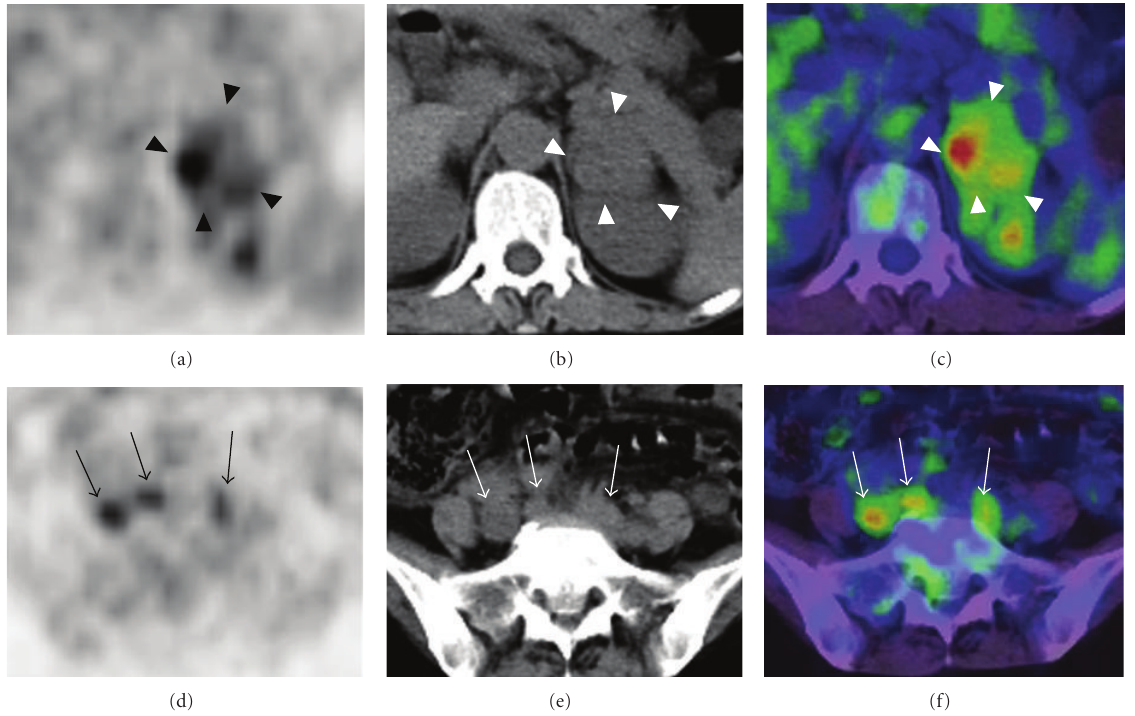
Figure 3: Axial PET (a), CT (b), and PET-CT fusion (c) images showed increased FDG uptake in the left adrenal mass (arrowheads). Increased uptake was also seen in the pelvic veins, consistent with a tumor thrombus ((d)–(f)) (arrows).